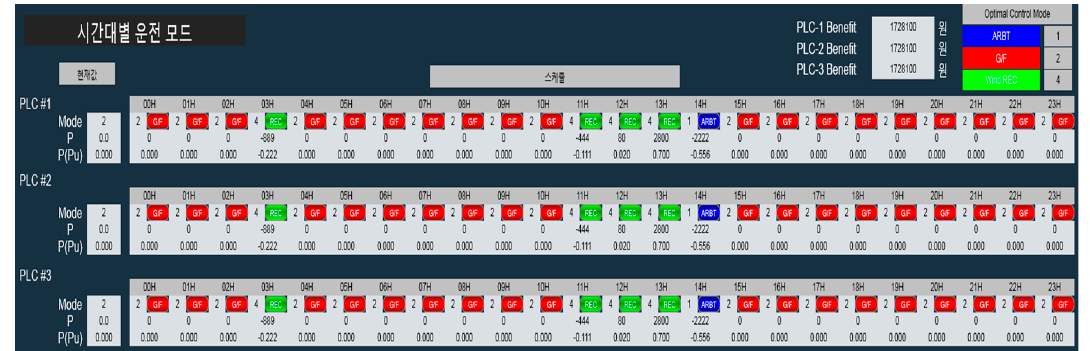
Figure 14. Scheduling results in TEMS.